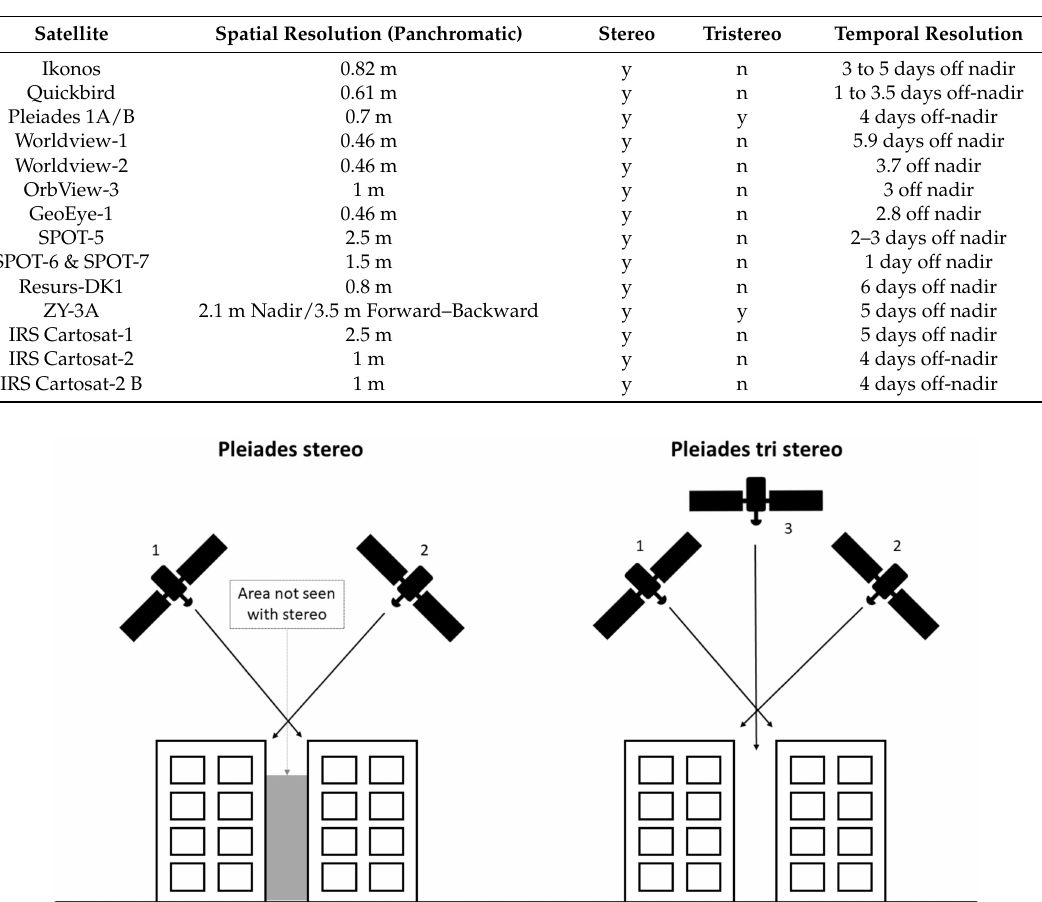
Table 1. VHR satellites with stereo and tri-stereo capabilities.